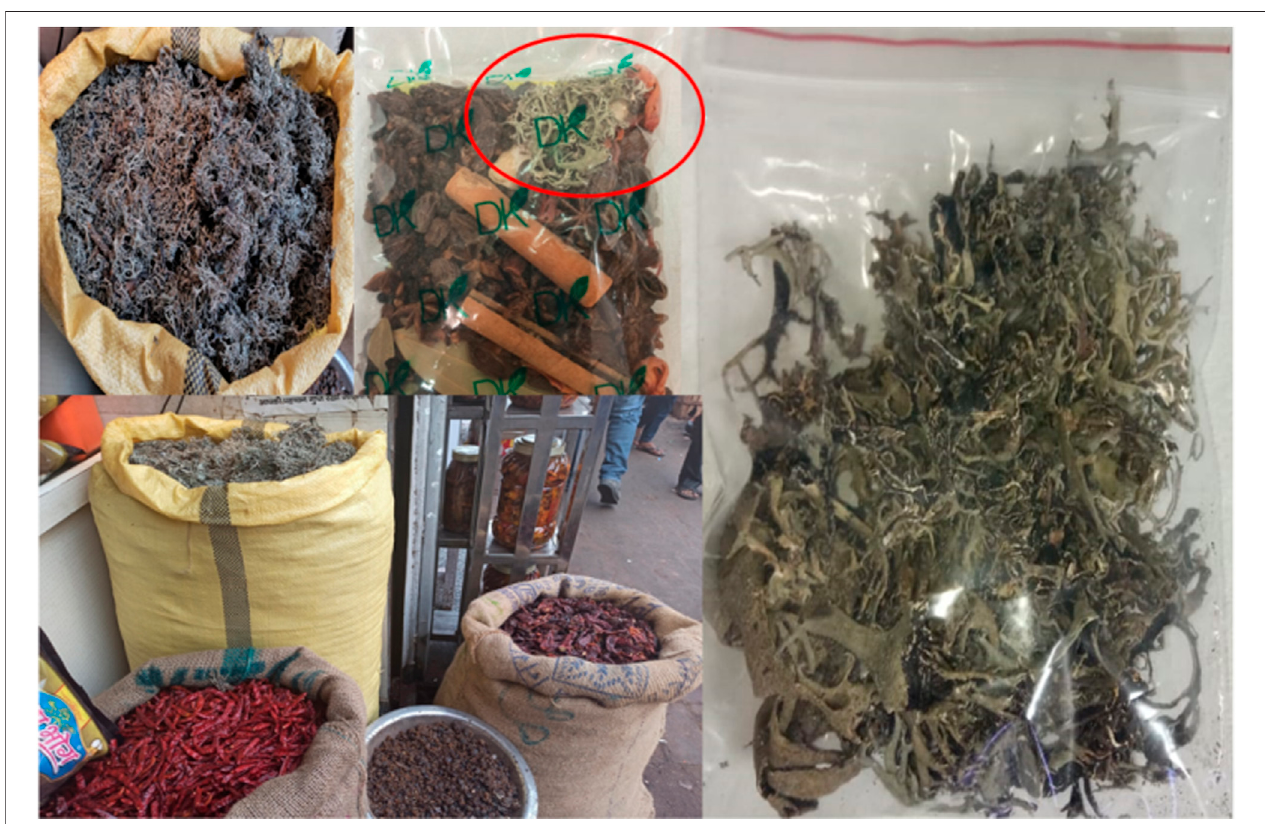
FIGURE 1 | Pseudevernia furfuracea as it is sold in the spice market khari baoli (New Delhi, India).